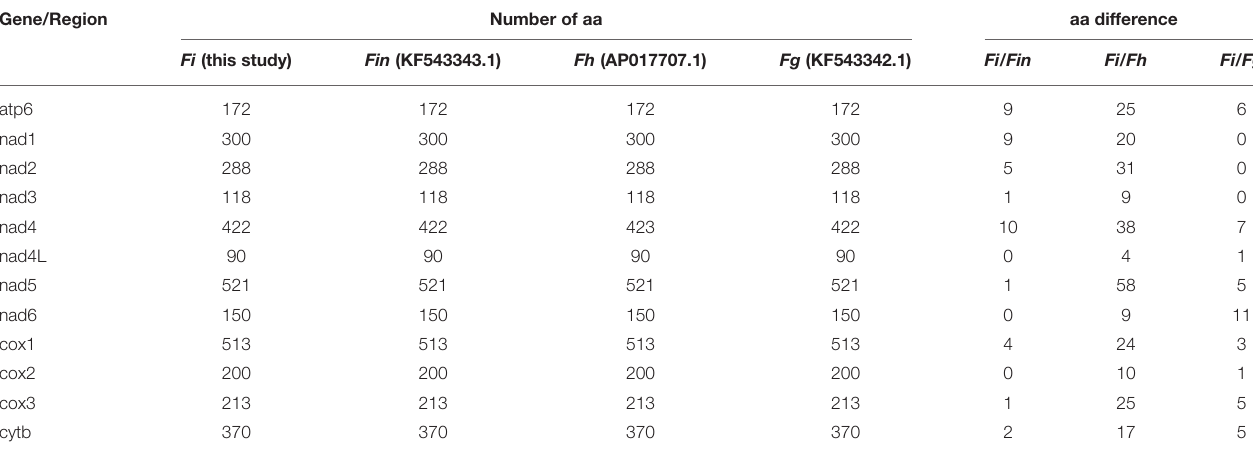
TABLE 6 | Amino acid (aa) sequence differences in each mt gene among F. intermediate, F. gigantica, and F. hepatica .